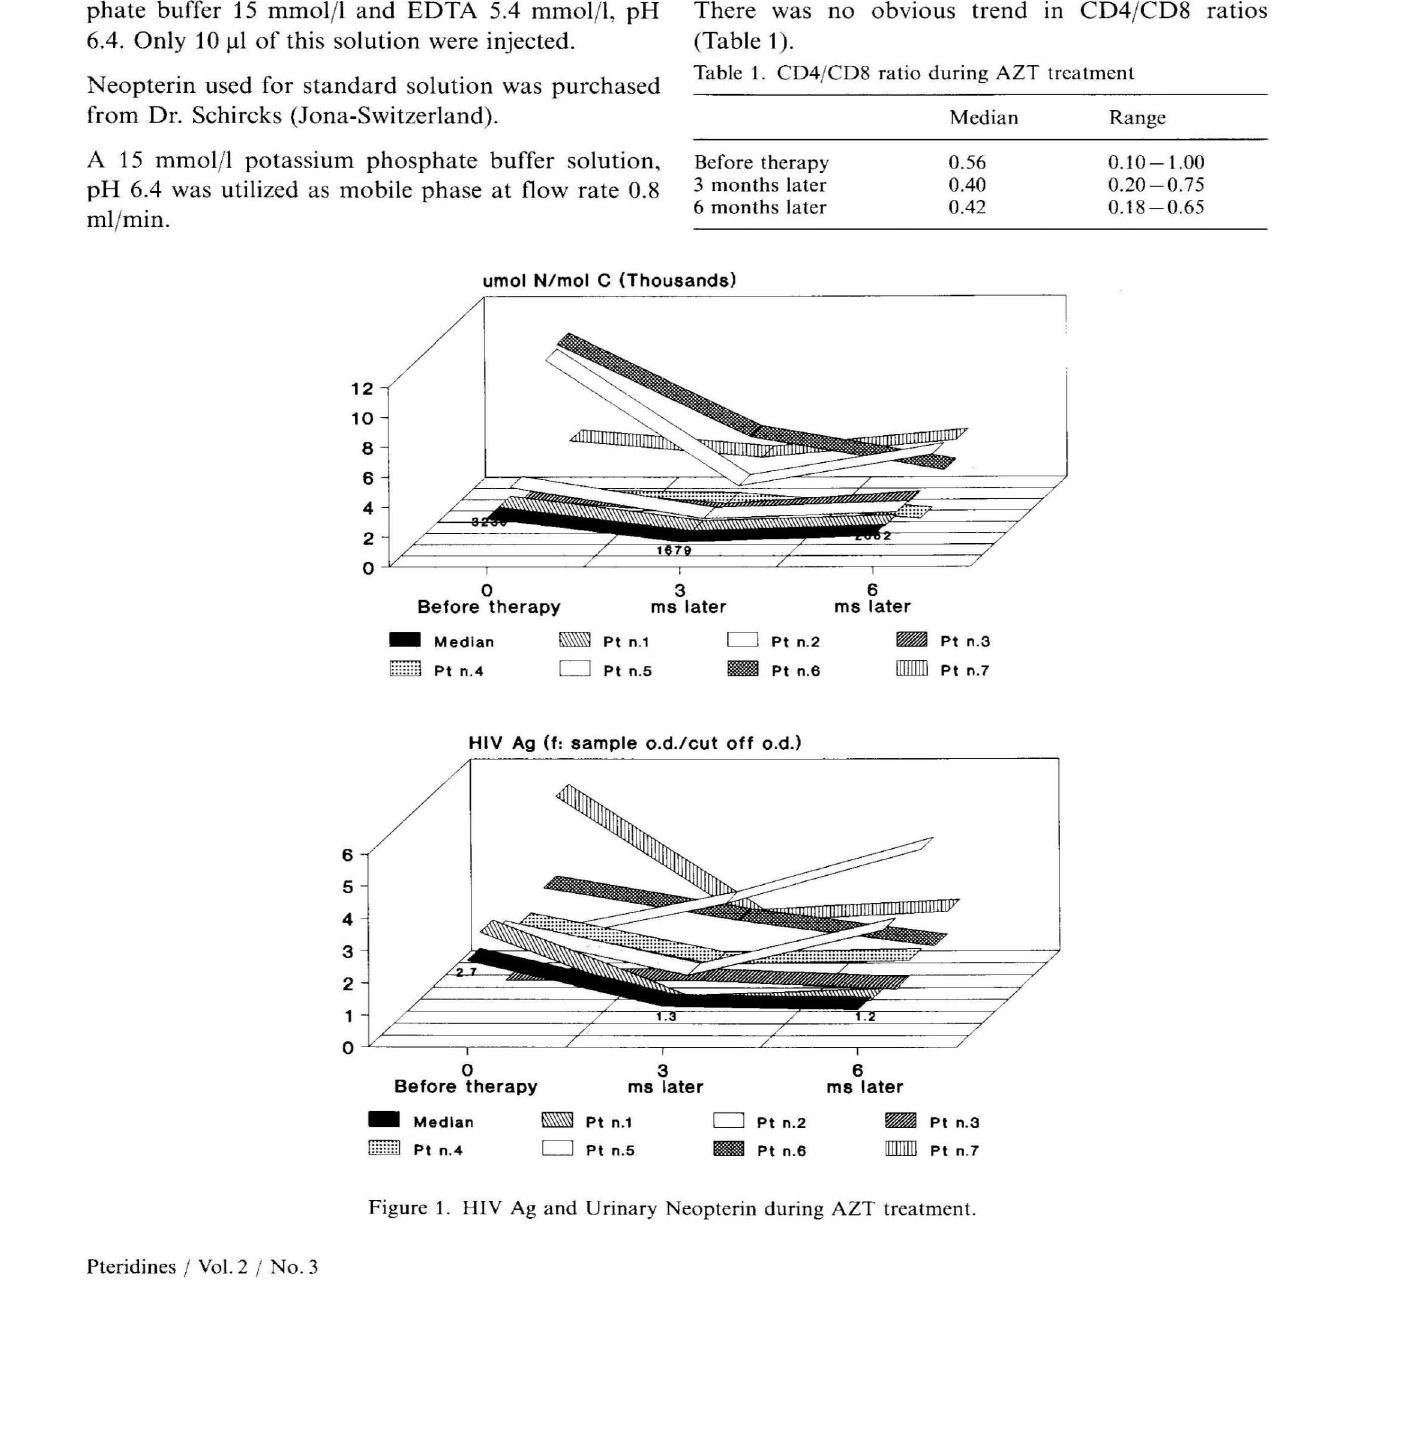
Figure 1. HIV Ag and Urinary Neopterin during AZT